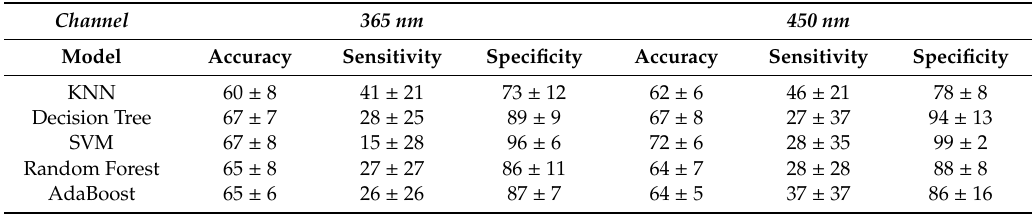
Table 1. Achieved results of Accuracy and Specificity in % for each classifier and each excitation channel for TEF measurements.